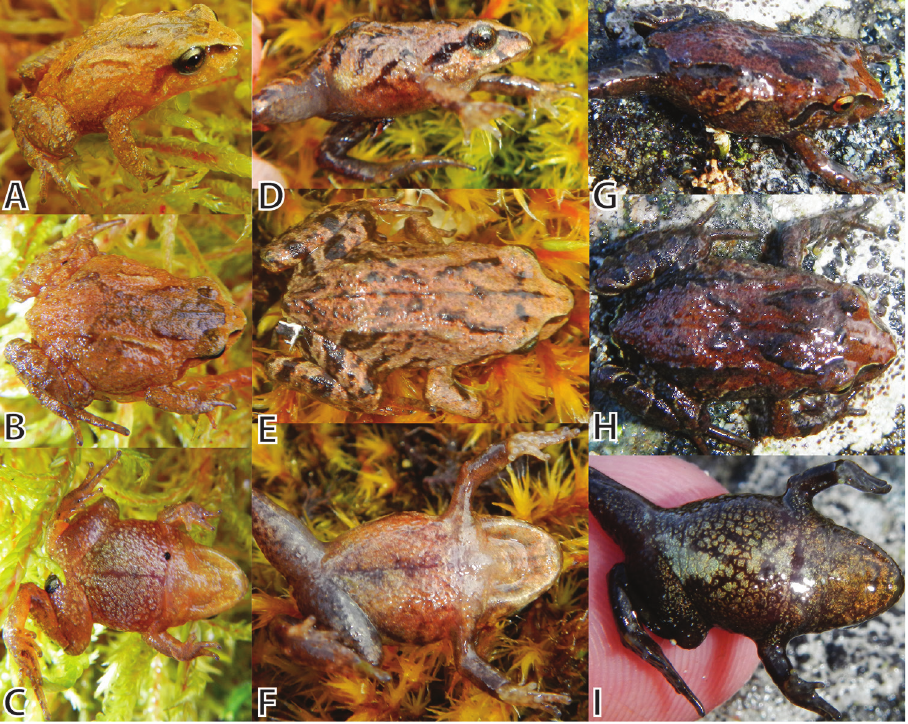
Figure 7. Variation of juvenile paratypes of Pristimantis attenboroughi sp. n. in dorsolateral, dorsal, and ventral views. A–C (MUSM 31990, SVL 14.0 mm) D–F (MUSM 31187, SVL 12.5 mm) G–I (MUSM 31200, SVL 14.0 mm). Photos by E.